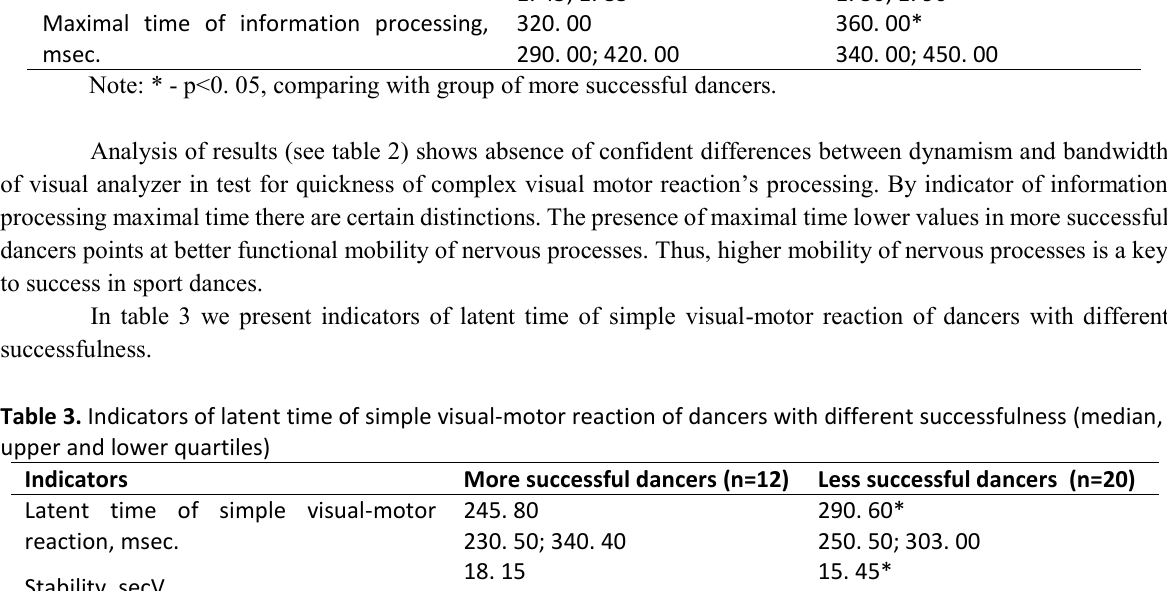
Table 2. Indicators of nervous processes’ functional mobility of dancers with different successfulness (median, upper and lower quartiles) Indicators Dynamism, conv. un. Bandwidth of visual analyzer, conv. un. Maximal time of information processing, msec.